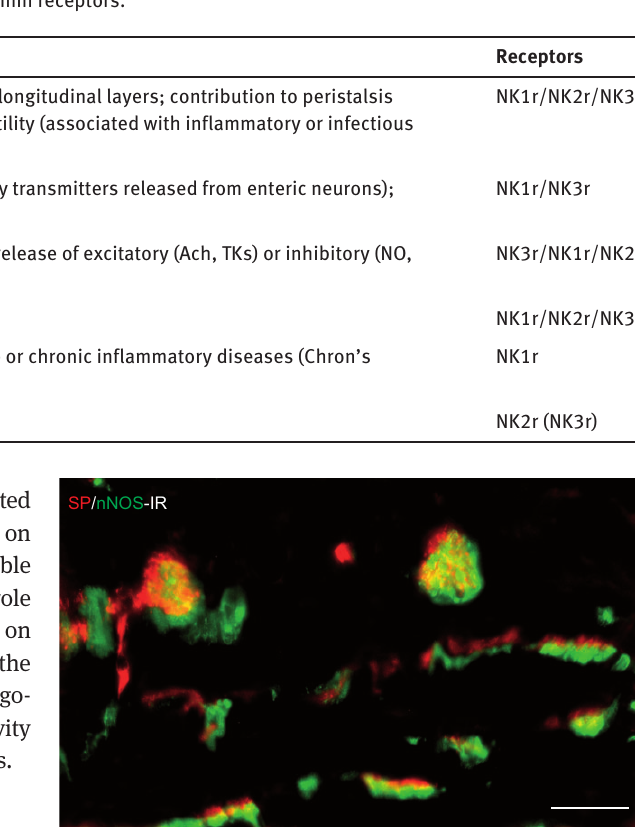
Figure 5 Rat colon. Double labeling with SP and nNOS β antibodies. Numerous SP-IR nerve endings (in red) are close to the nNOS-IR neurons (in green) and the intramuscular SP-IR nerve fibers run parallel to the nNOS-IR ones. Calibration bar, 40 μ m (Vannucchi, Unpublished